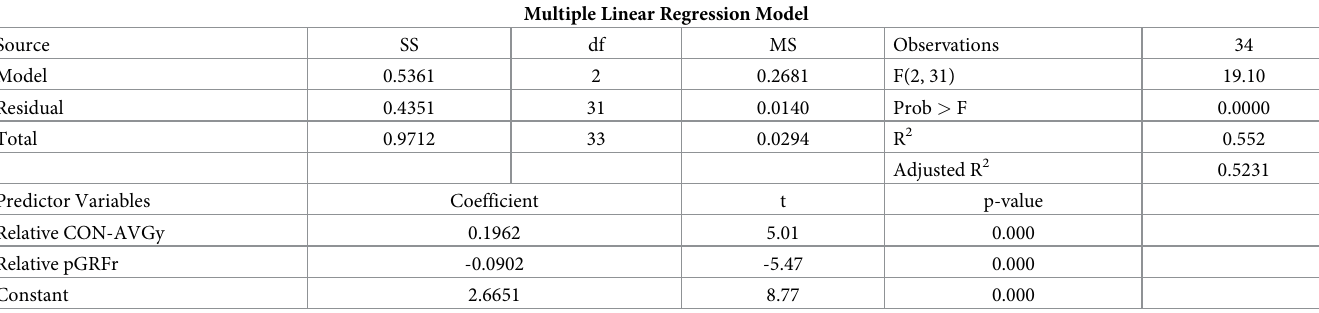
Table 5. Multiple linear regression model predicting lateral jump distance; derived with trial subset variables.